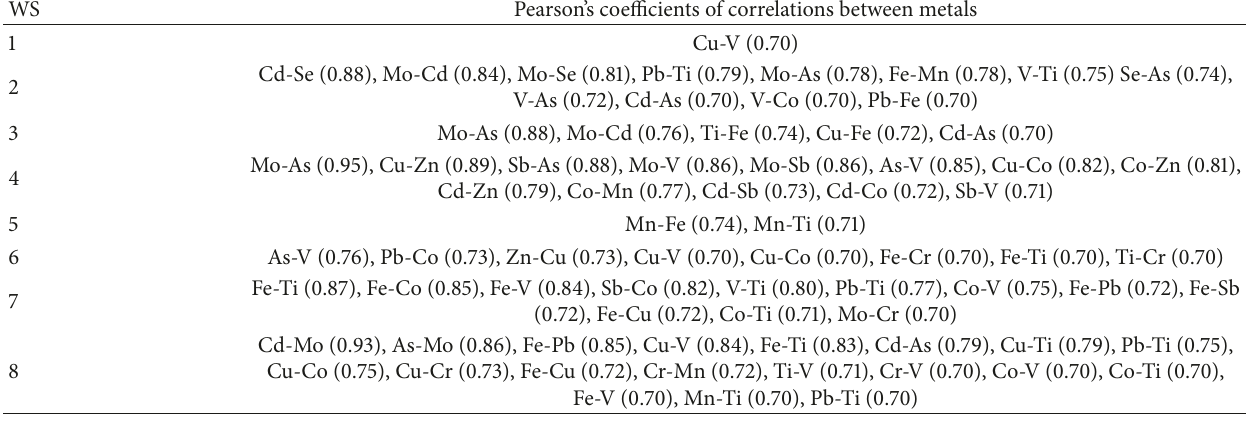
Table 4: Correlation between metals in water of the Voghji River and its tributaries ( 𝑟 > 0.7). WS Pearson’s coefficients of correlations between metals